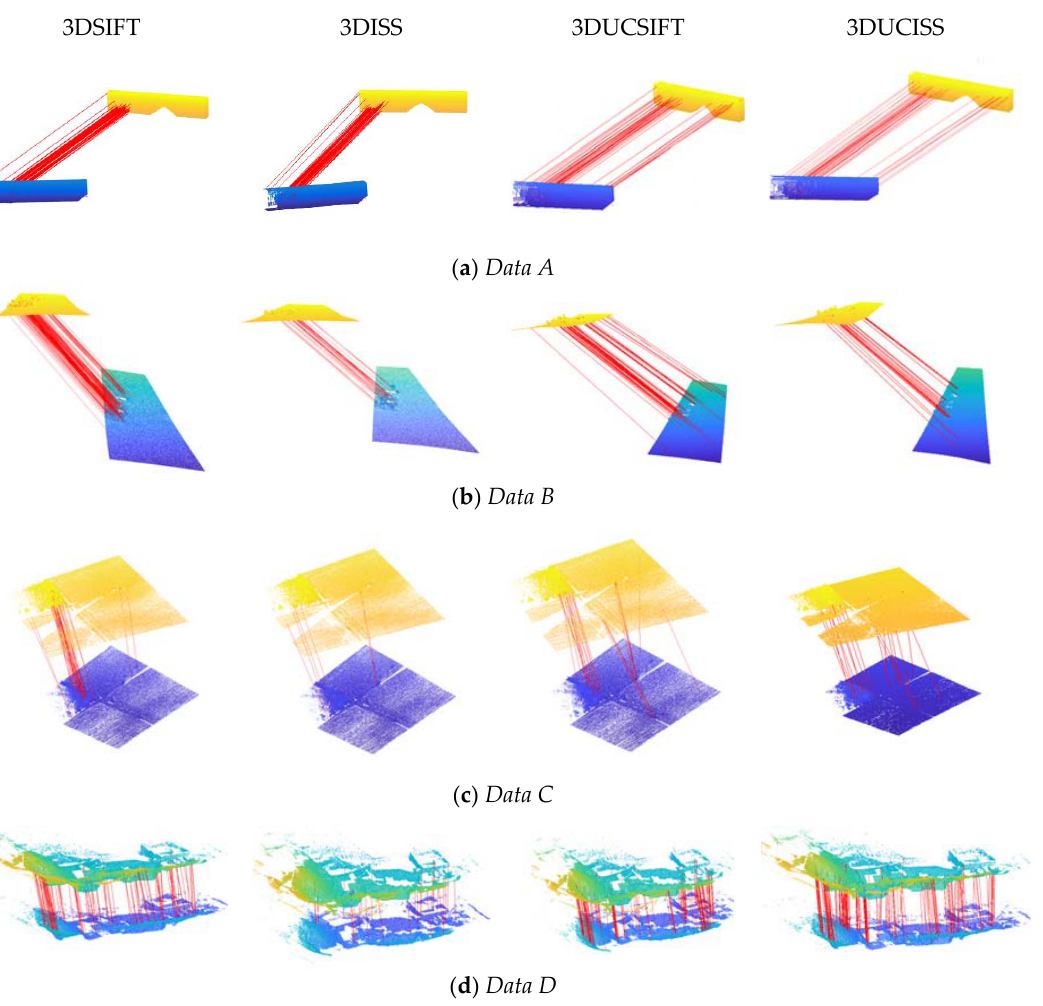
Figure 10. Displaying of correspondence process using 3D SIFT, 3D ISS standard detectors, and the proposed method. Table 2. Results of comparison of the proposed method and standard methods. mr is the mean of resolution.